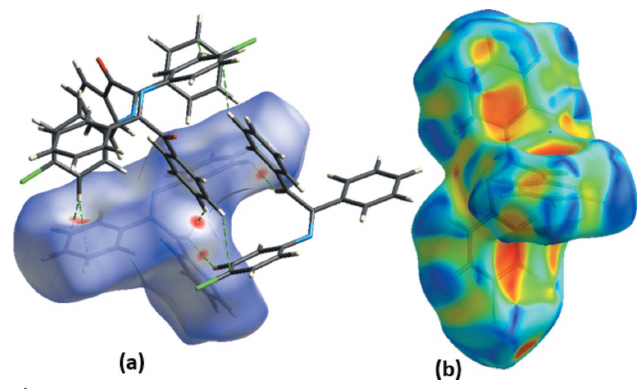
Figure 4 HS mapped over ( a ) d norm , showing the C—H (cid:3)(cid:3)(cid:3) O and C—H (cid:3)(cid:3)(cid:3) (cid:2) interactions, and ( b )